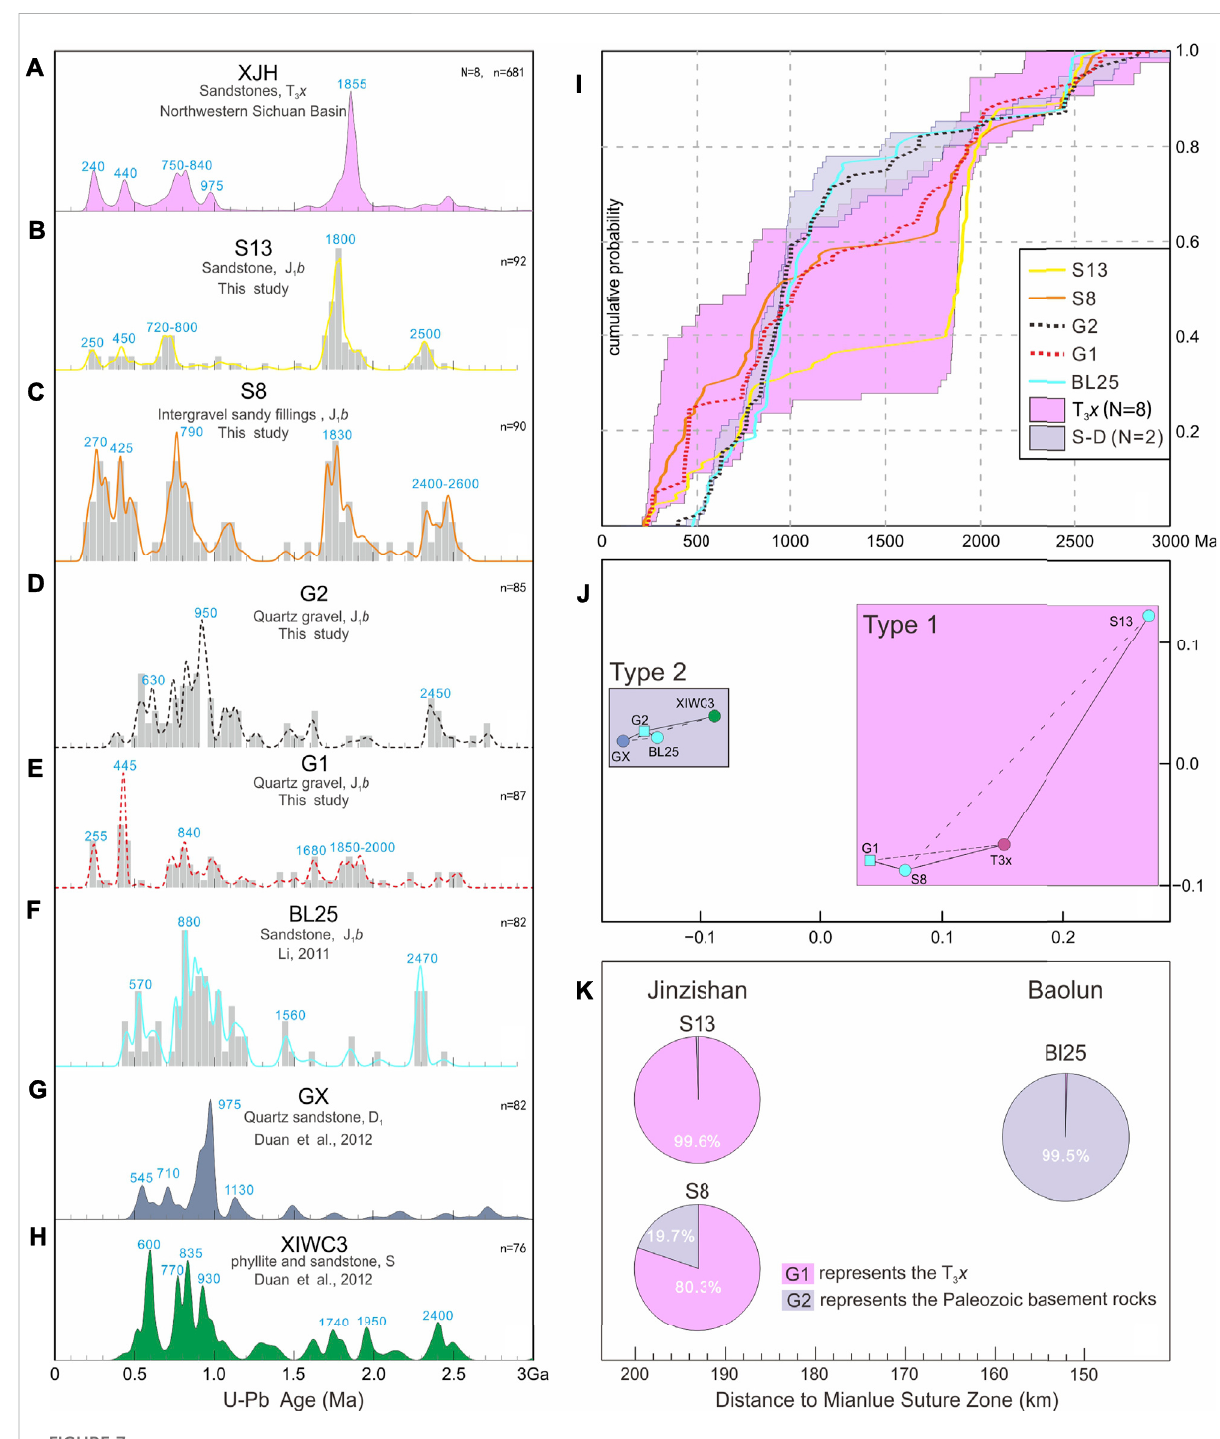
FIGURE 7 (A – H) Zircon U – Pb age cumulative probability distribution for each sample. XJH: Spectra of Upper Triassic Xujiahe Formation sediments in northwestern Sichuan Basin are taken from previous studies (Chen et al., 2011; Luo et al., 2014; Shao et al., 2016; Mu et al., 2019); G1, G2, S8 and S13 are new samples collected from the Lower Jurassic strata in the Jinzishan section; BLl25 is a Lower Jurassic sandstone sample from Li. (2013); Lower Devonian sample GX and Silurian sample XIWC3 are thrust belt source units in Longmen Shan, from Vermeesch, 2018 and Duan et al. (2012), respectively. (I) Cumulative distribution plot (CDF) of all samples; (J) Multidimensional scaling map (Vermeesch, 2018), showing the distinct signature of Baitianba Formation, Type 1 is similar to Upper Triassic continental deposits, and Type 2 is a population distribution similar to that of Lower Paleozoic Marine quartz-rich sandstones of the Longmen Shan thrust belt. The multi-dimensional scaling (MDS) map uses the Kolmogorov – Smirnov (KS) statistic for detrital zircon U – Pb datasets (Stevens et al., 2013; Vermeesch, 2018). (K) Unmixing detrital geochronology age